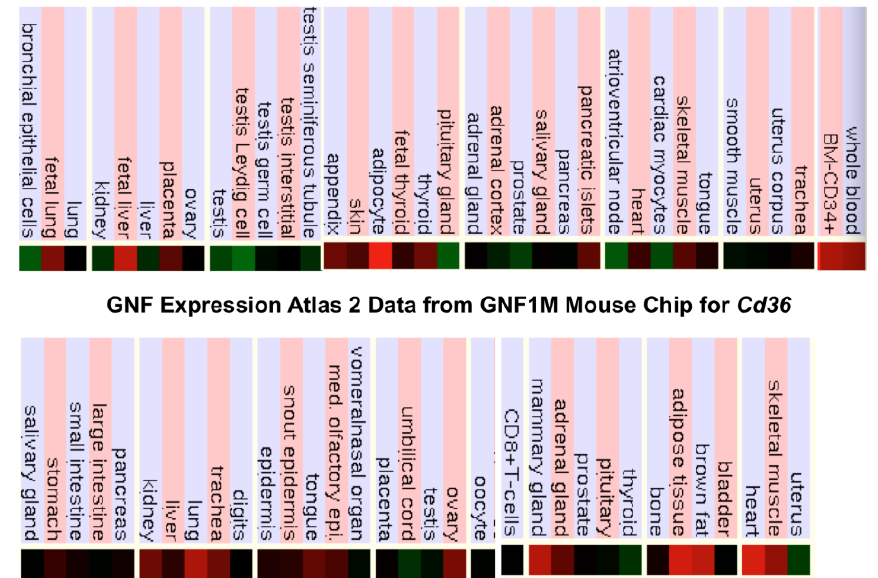
Figure 4. Comparative Tissue Expression for Human and Mouse CD36 Genes. Expression ‘heat maps’ (GNF Expression Atlas 2 data) (http://biogps.gnf.org) were examined for comparative gene expression levels among human and mouse tissues for CD36 genes showing high (red); intermediate (black); and low (green) expression levels [75]. Derived from human and mouse genome browsers (http://genome.ucsc.edu)